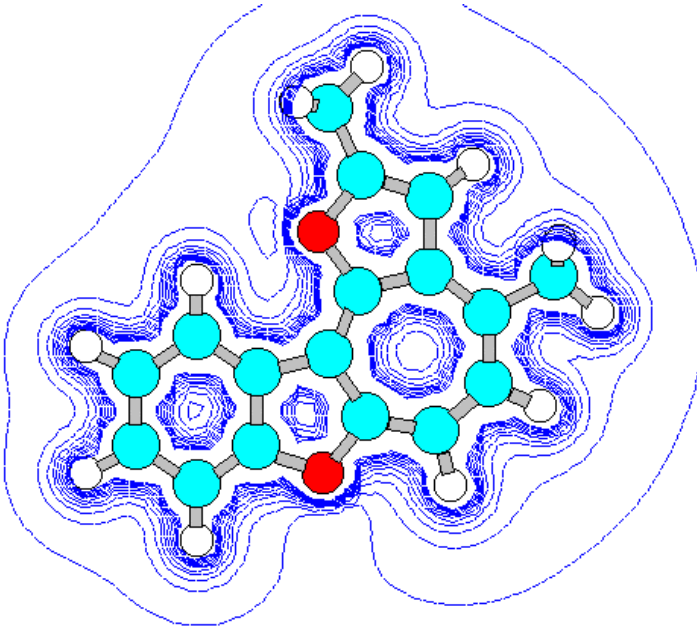
Figure 2. Energy minimized structure (AM1) of cation B generated by HyperChem 5.0 program (with 2Dcontour map of electrostatic potential).